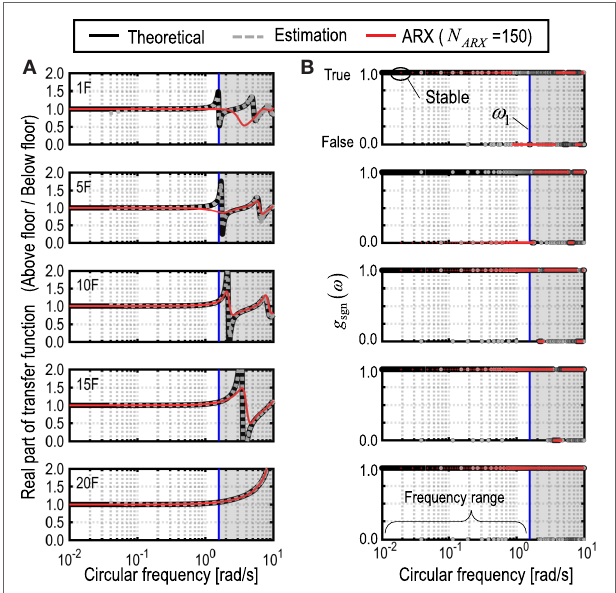
FIGURE 2 | Application of quantitative index to determine filtering parameters . (A) Real part of transfer function and (B) Boolean data type function in Eq.